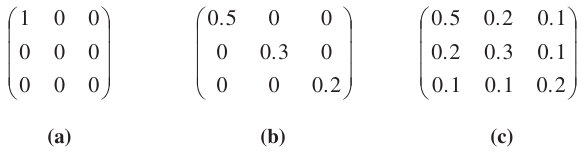
FIG. 15. Examples of class density matrix as appeared in Ref. 54: (cid:1) a (cid:2) the entire class uses model 1 consistently, (cid:1) b (cid:2) the class con- sists of three groups of students each with a consistent model, and (cid:1) c (cid:2) students use multiple models inconsistently.